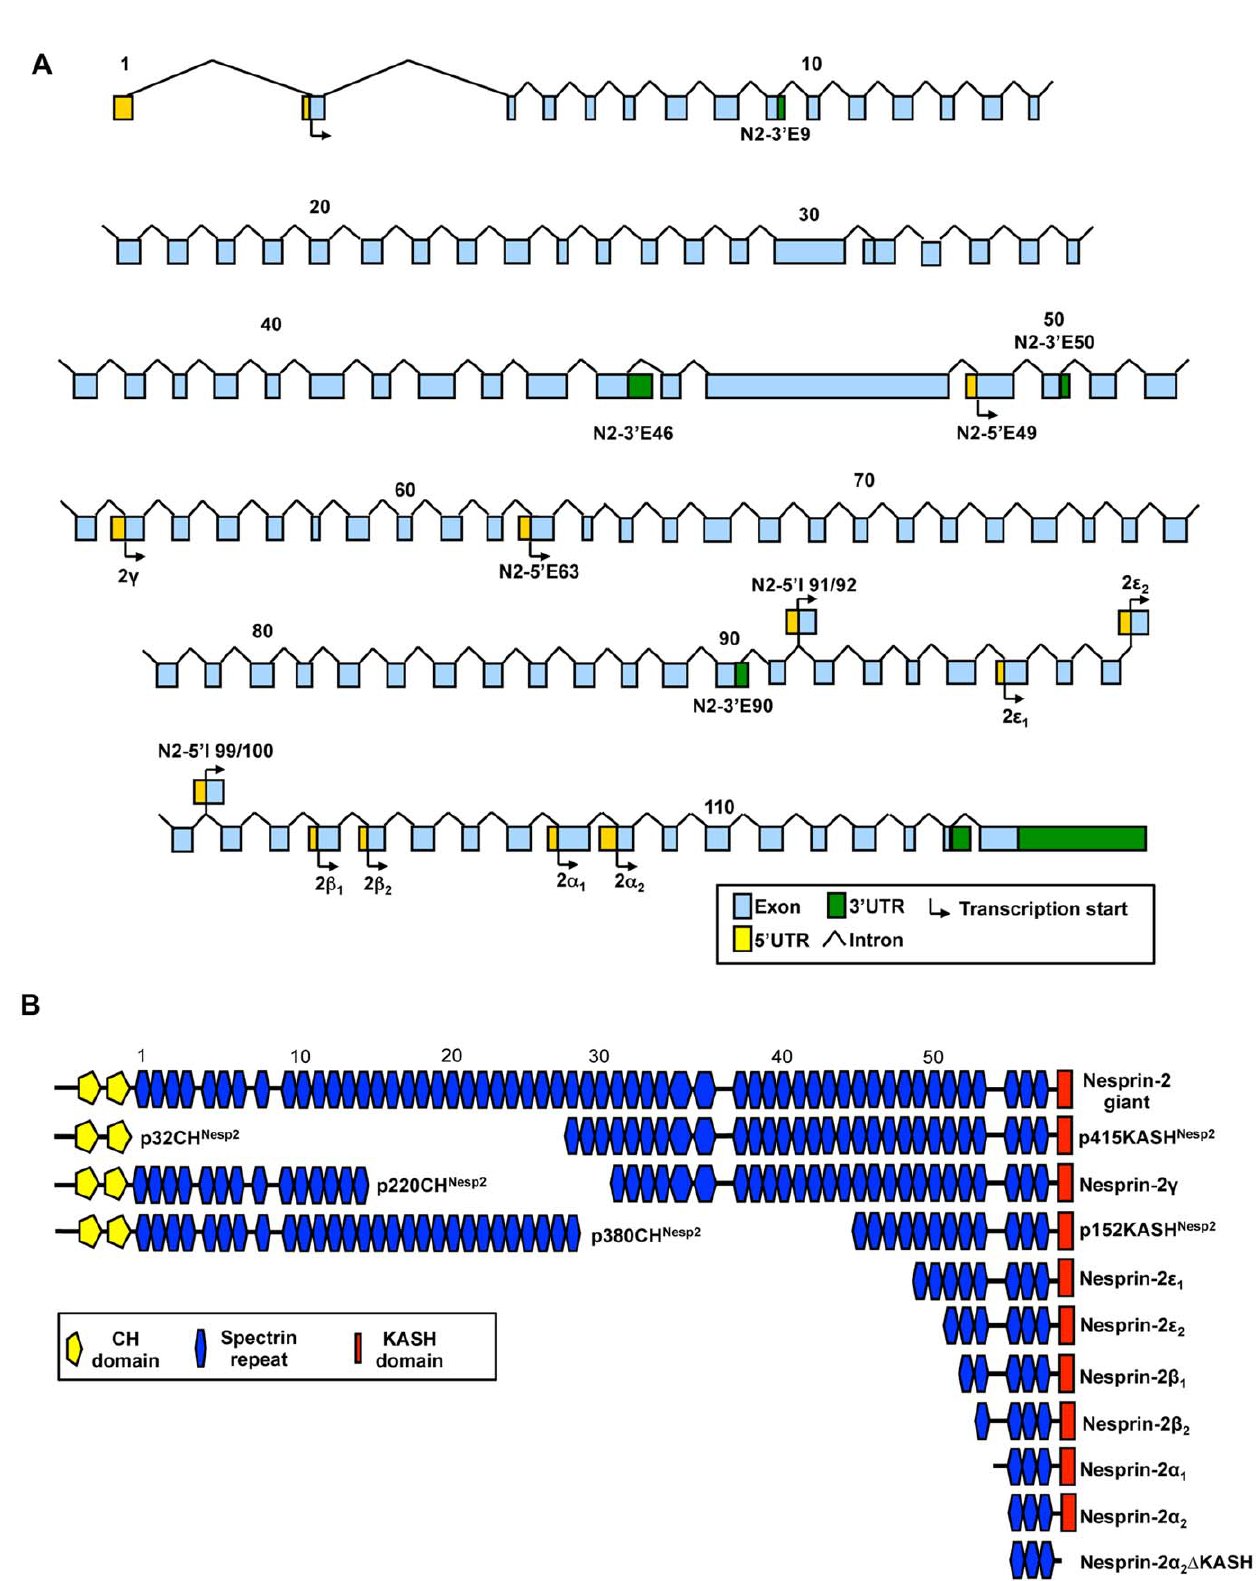
Figure 3. Potential nesprin-2 isoforms. A) Genomic map of the nesprin-2 gene highlighting the positions of the nesprin-1 UTRs identified to date. B) Proposed nesprin-2 isoforms created by alternative transcription. SRs are numbered and shown according to the scheme of Simpson and Roberts 2008 and are shown to scale.